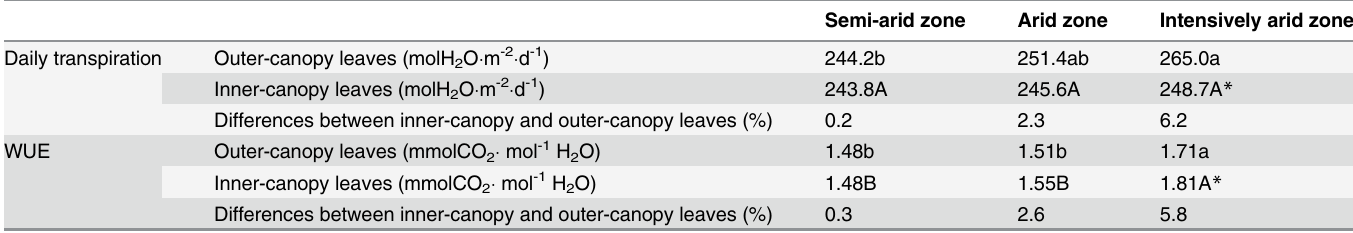
Table 3. Transpiration rates and water use ef fi ciency (WUE) of inner-canopy and outer-canopy leaves of C . stenophylla in the semi-arid, arid and intensively arid zones (n = 3).